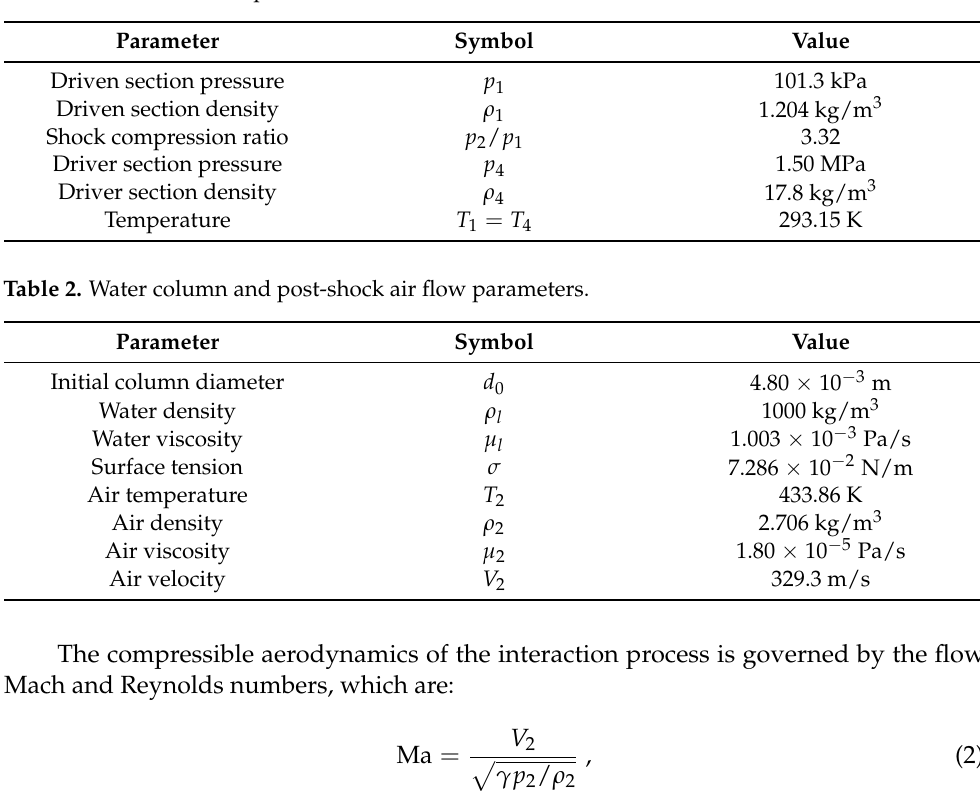
Table 1. Shock tube flow parameters.